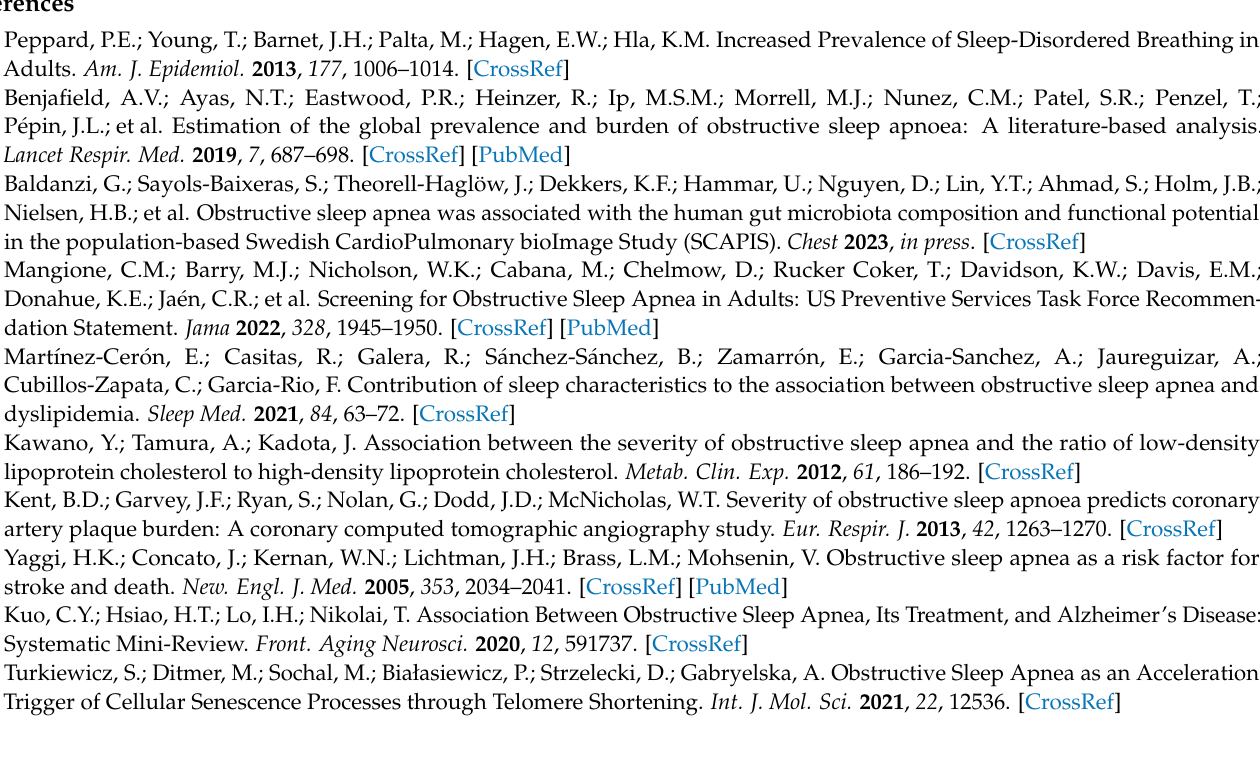
Figure S2: Visualization of the chromosomal positions of the nodes in the ceRNA networks. The green nodes represent mRNAs, red nodes represent miRNAs, and blue nodes represent lncRNAs; Figure S3: The predicted miRNA binding sites of the ceRNA networks were identified by the miRanda database; Table S1: qRT-PCR primer